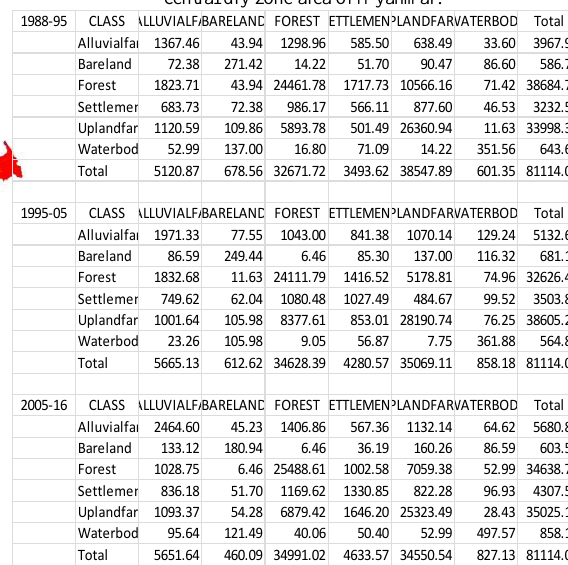
TABLE 2. Cross table of land use/cover classes from 1988 to 2016 for central dry zone area of